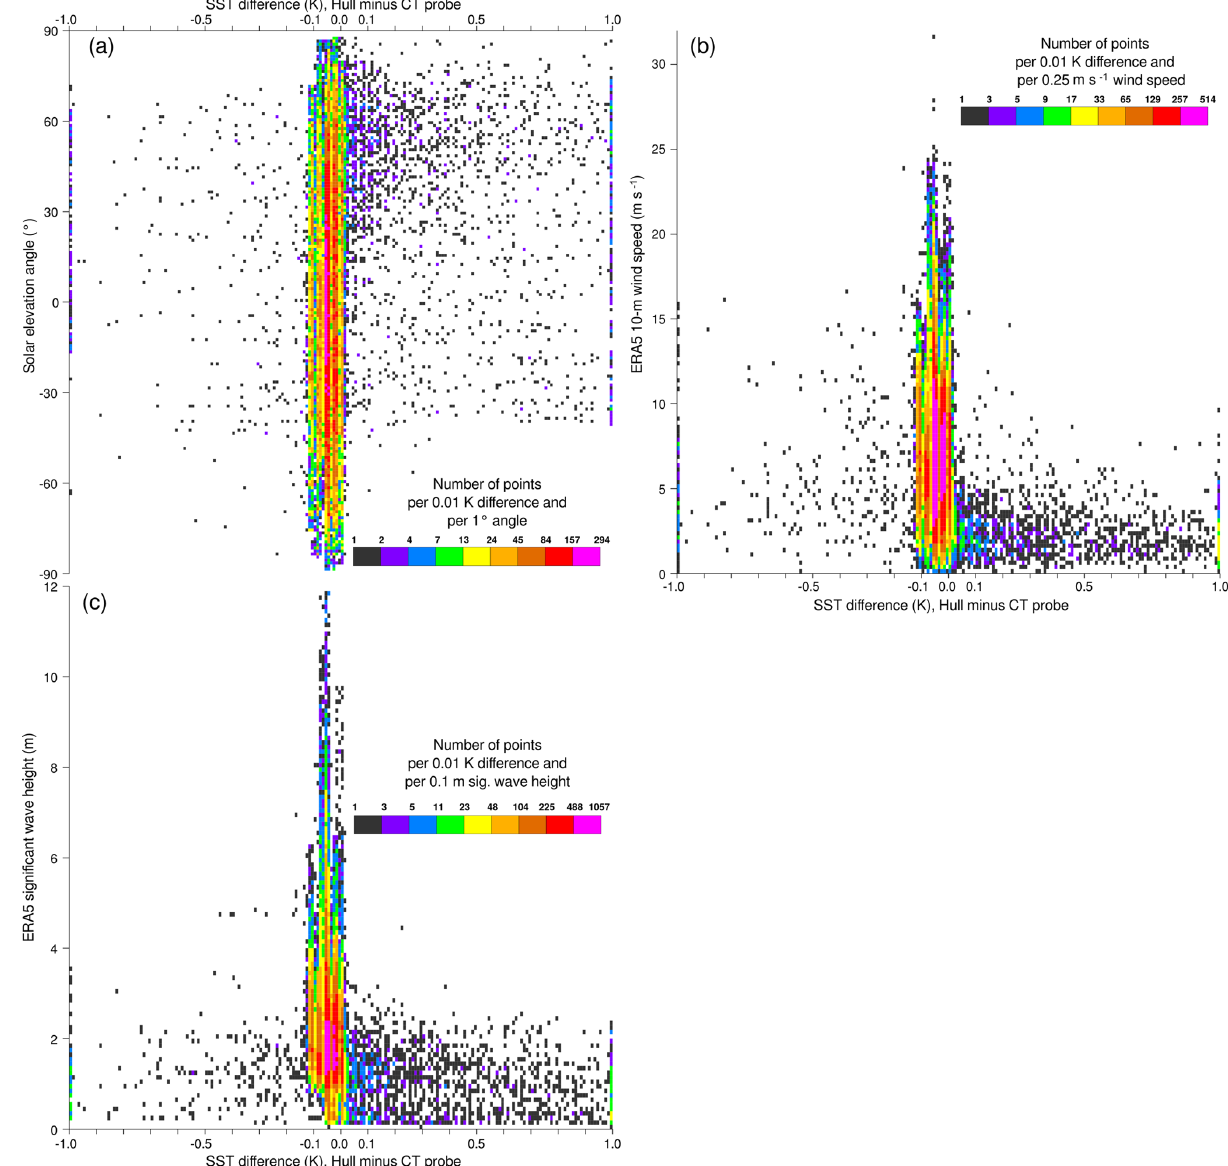
Figure 2. Differences between the two SST sensors from all HRSST-2 SVP-BS buoys, as a function of (a) solar elevation angle and ERA5 estimates for (b) 10m wind speed and (c) significant wave